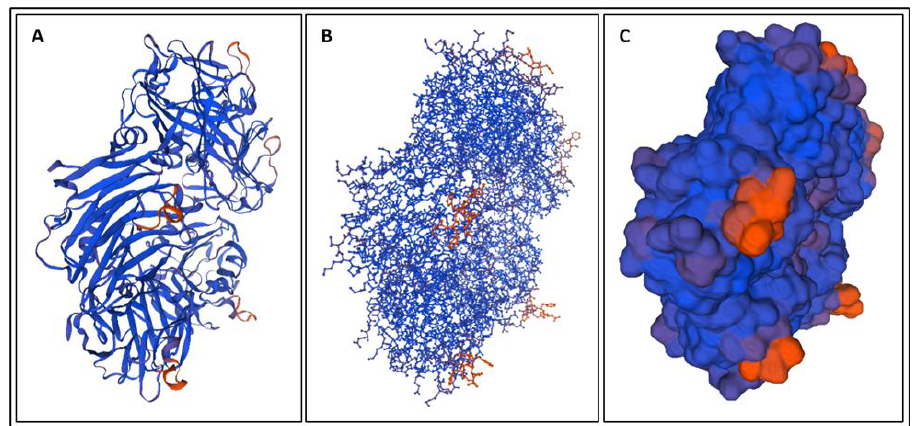
Figure 9. ( A ) A cartoon model, ( B ) a ball-and-stick model, and ( C ) a surface model of NSE made using amino acid sequences from the UniProt database [38].